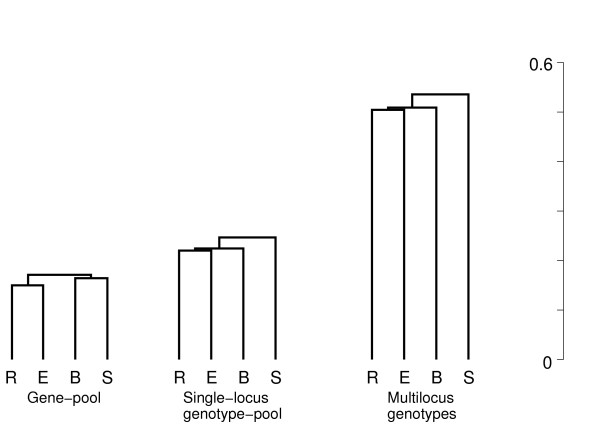
UPGMA dendrograms at three levels of genetic integration in four oak stands. For six microsatellite loci scored in four stands of oak (R, B, S, E), UPGMA dendrograms were constructed from the matrices of genetic distances Δ between stands in Tab. 1. Within each dendrogram, the quantitative differences between clusters are weak. The gene-pool dendrogram differs qualitatively, i.e., topologically, from the topologically identical dendrograms of the higher levels. The significantly large increase in the mean pairwise distance, and thus in the length of the dendrograms, with level of integration implies that the stands show differentiation for their forms of homologous gene association and, even more so, non-homologous association.